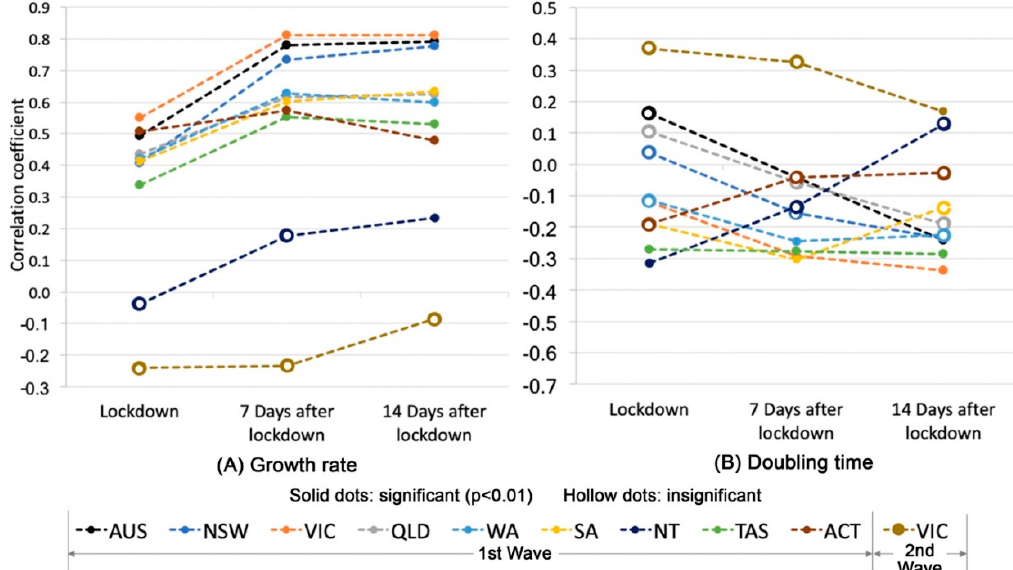
Figure 5. Correlation between CMI and growth rates ( A ), and between CMI and doubling time ( B ) in Australia and each state/territory over three periods of time. Note: the values of correlation coefficients are provided in Supplementary Materials.